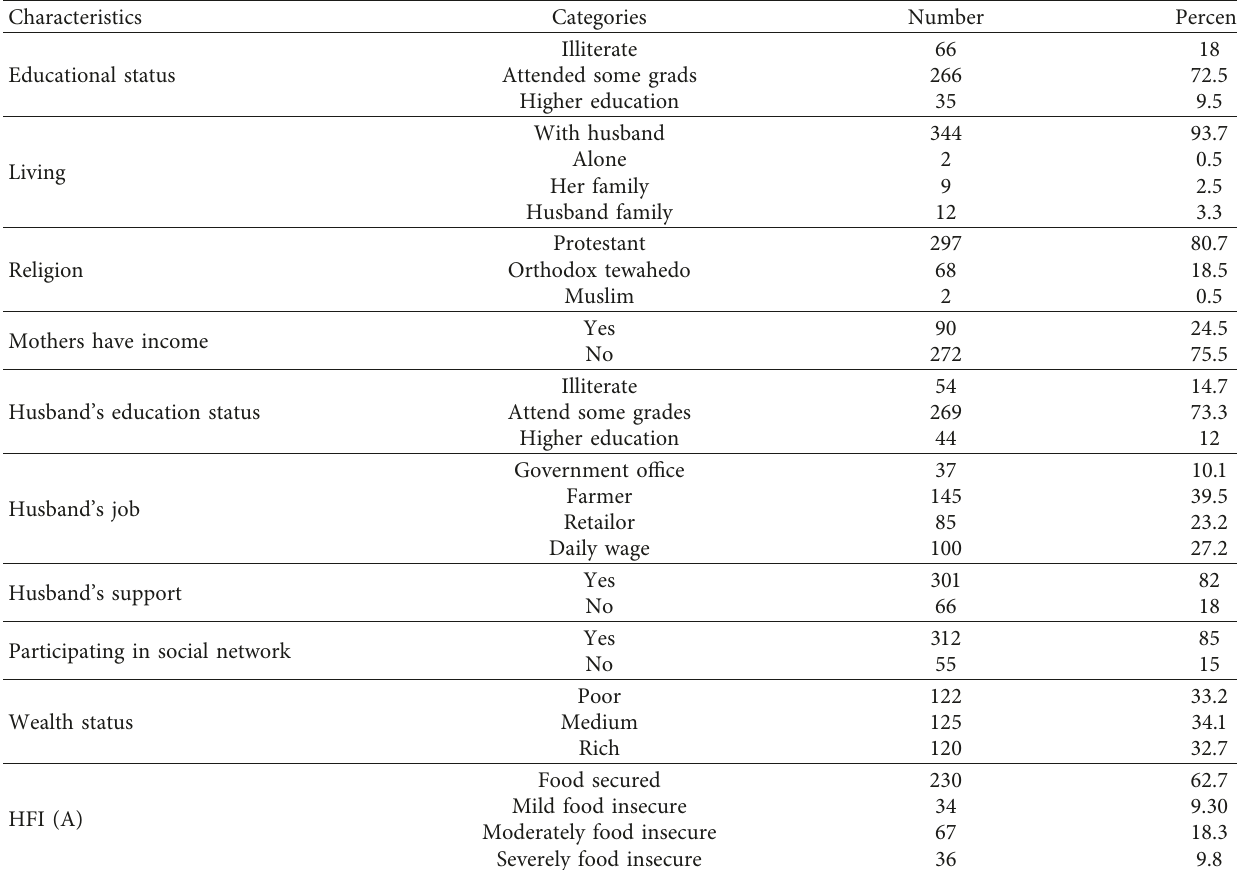
Table 1: Demographic and socioeconomic characteristics of pregnant mothers in South West Ethiopia in February 2020 ( n � 367). Characteristics